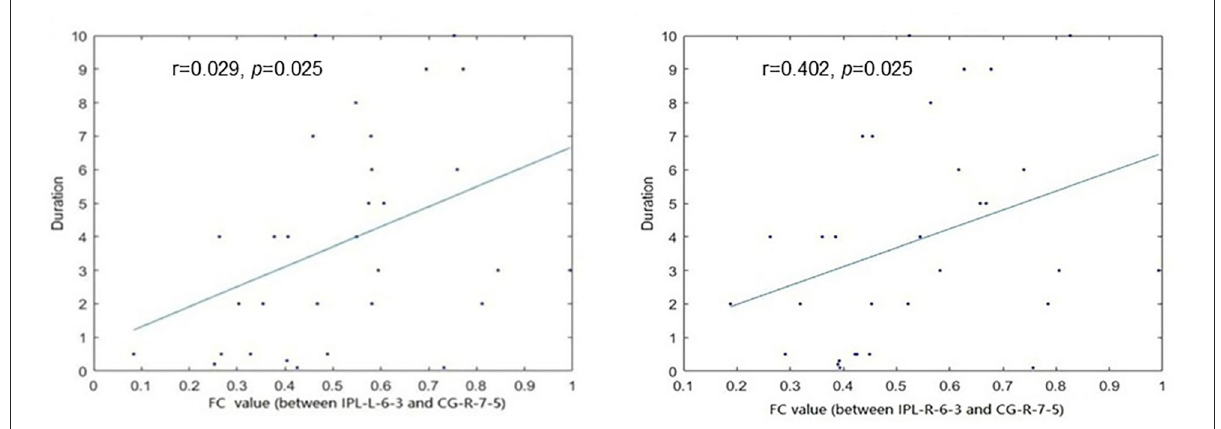
FIGURE4 The functional connectivity (FC) between the bilateral inferior parietal lobule (IPL) and right Cingulate gyrus (CG) was significantly correlated with the duration of MA